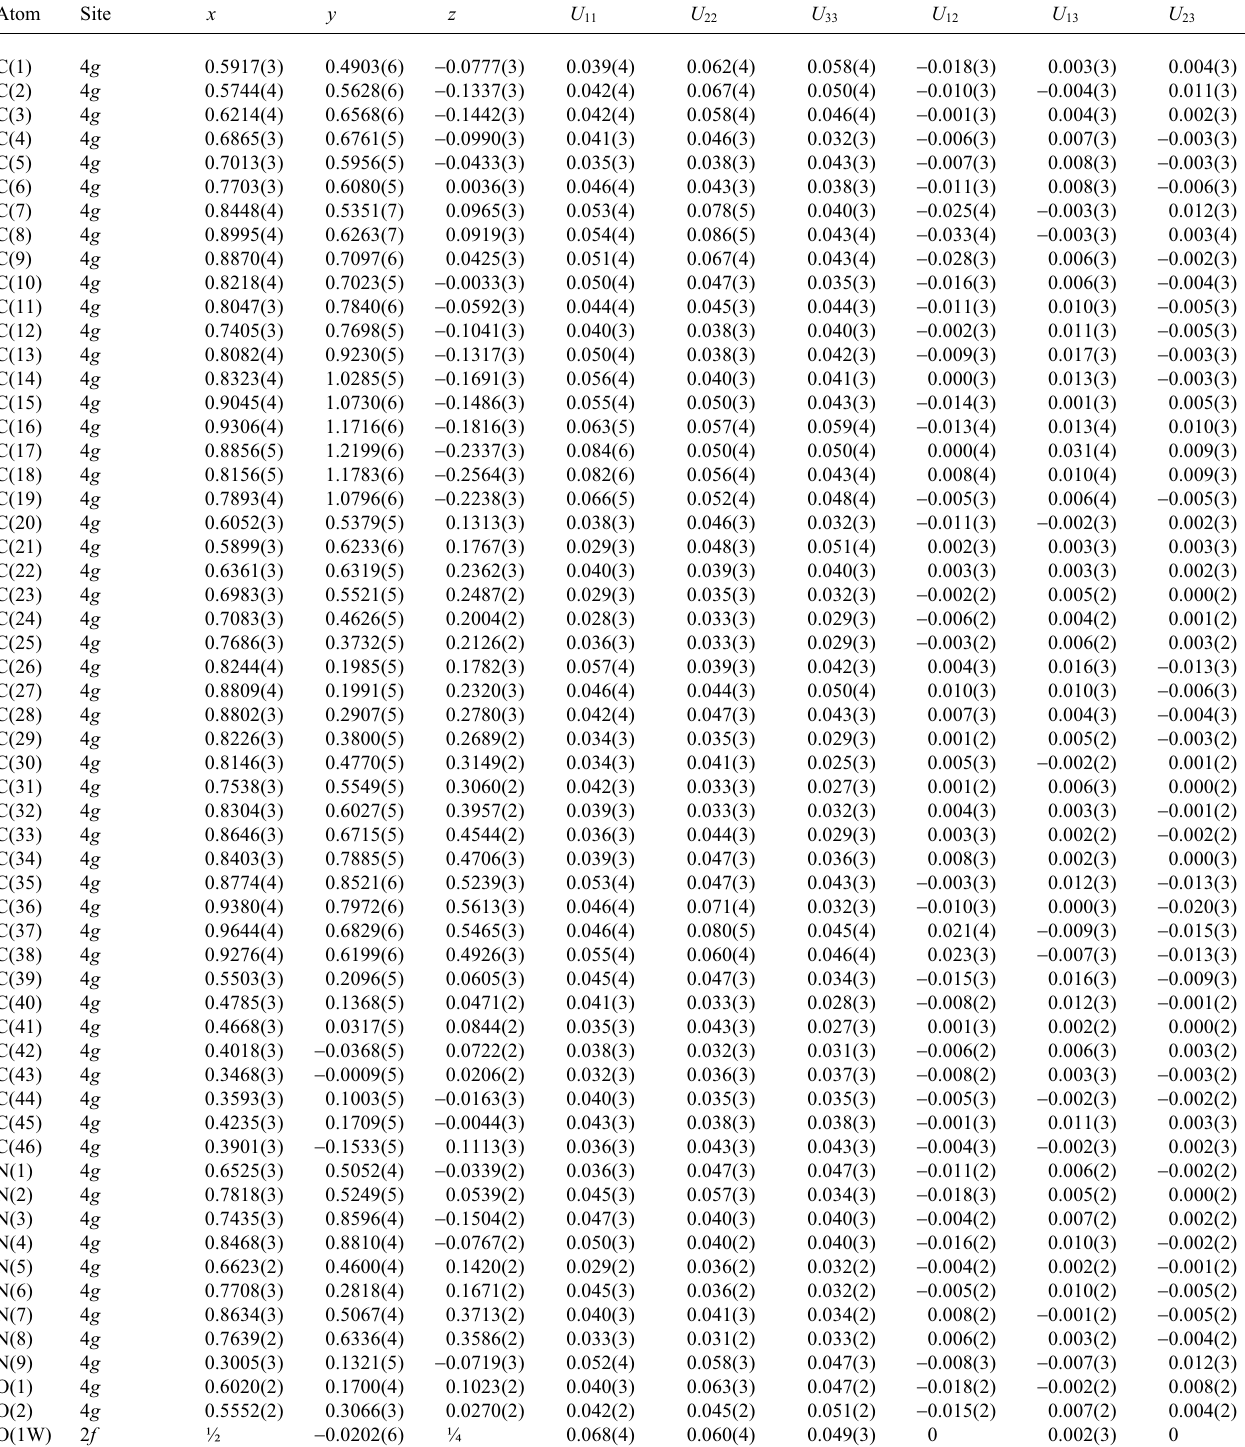
Table 3. Atomic coordinates and displacement parameters (in Å 2